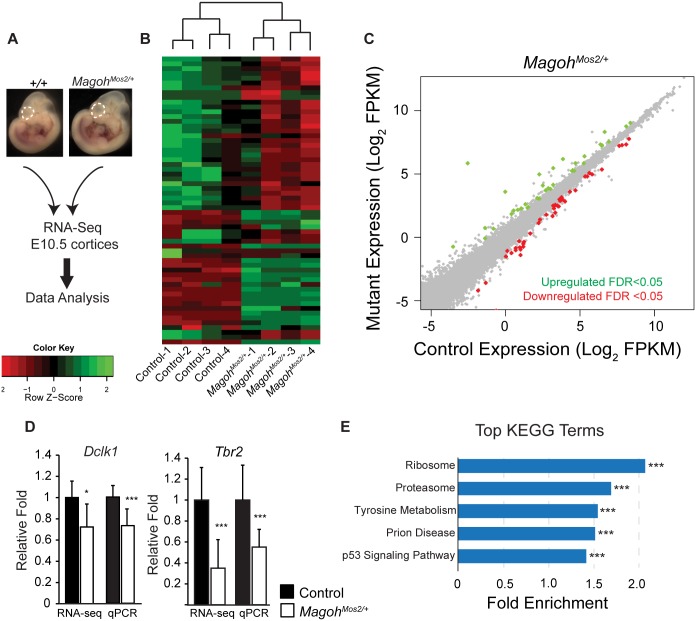
Transcriptome analyses of E10.5 Magoh germline haploinsufficient brains identifies alterations in ribosome and p53 signaling pathways.(A) Diagrammatic overview of RNA sequencing analysis of E10.5 neocortices (dotted lines) from indicated genotypes. (B) Heatmaps showing z-score transformed normalized expression for control and MagohMos2/+. Genes and samples were clustered using correlation distance with complete linkage. (C) Scatter plot of transcripts significantly upregulated (green dots) and downregulated (red dots) in E10.5 MagohMos2/+ cortices (q<0.05), n = 4 biological replicates each. (D) Validation and RNA-seq values for Dclk1 and Tbr2 in indicated E11.5 mutant dorsal neocortices. Controls were normalized to 1.0. (E) Graph depicting top ranked KEGG terms by GSEA analysis in MagohMos2/+ showing corresponding fold enrichment. Student’s t test (D), Error bars, S.D. *, p<0.05, ***, p<0.001.